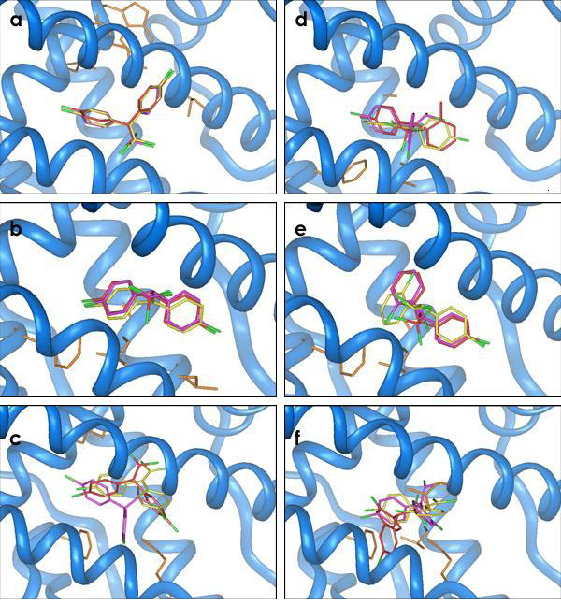
Docking results for p,p-isomers on the left and o,p-isomers on the right. Panels a and d refers to hERα, b and e to hPR, c and f to rAR. Residues shared by p,p- and o,p-isomers respectively for each receptor are coloured in orange. Ligands color code: red:p,p- and o,p-DDT; yellow: p,p- and o,p-DDE; purple: p,p- and o,p-DDD; green: chlorine atoms.